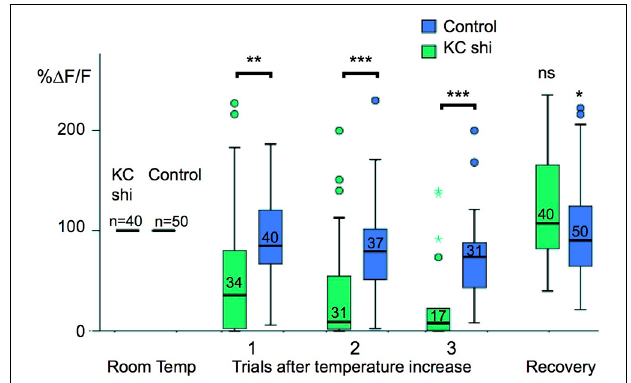
FIGURE 5 | Odor-evoked responses in the larval APL are dependent on KC input. Box plots of larval APL responses to ethyl acetate, visualized using NP2631-GAL4 and UAS-GCaMP3 , at room temperature, and three successive trials after a shift to restrictive temperature, when KC neurotransmission is blocked by expression of shibire ts using MB247-LexA , (KC shi), or in control larvae that are treated identically but do not express shibire ts . Each value of (cid:2) F / F was normalized to the average response value of the same calyx at room temperature (100%). Shibire-expressing calyces (KC shi) were compared to non-expressing calyces at each time point; responses after returning to room temperature (“Recovery”) were compared to responses of the same calyx prior to temperature shift. Pairwise comparisons were carried out using Mann-Whitney U -tests (ns, not significant; ∗ P < 0 . 05; ∗∗ P < 0 . 005; ∗∗∗ P < 0 . 001). Boxes show the second and third quartiles, separated by the median; whiskers extend 1.5 × the length of each box, or to the most extreme value, whichever is shorter; outliers are labeled as circles and colored asterisks. A small number of individual outliers lay outside the range shown in the graph, but were included in the statistical analysis. The number of temperature shifts analyzed for each condition is shown just above each median bar.